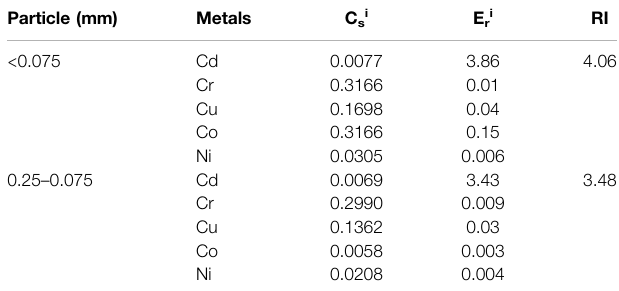
TABLE 8 | Hakanson potential ecological risk index of fl y ash under different particle size